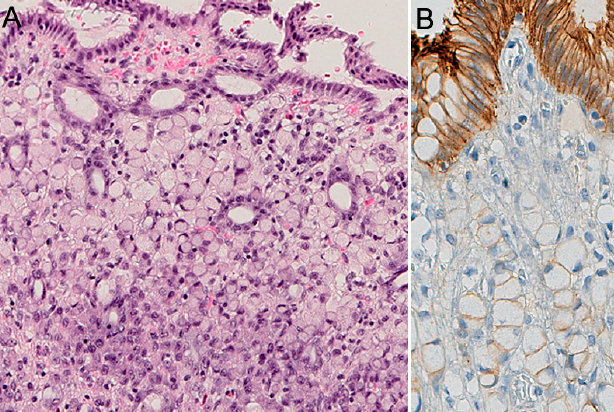
Figure 2. Intramucosal HDGC, pT1a. ( A ) Signet ring cells are larger at the surface, foveolar type; in the deeper zone, at the level of the isthmus, the neoplastic cells are much smaller, immature type. ( B ) E-cadherin expression (IHC) shows absence or marked decrease of E-cadherin at the cell membrane of signet ring